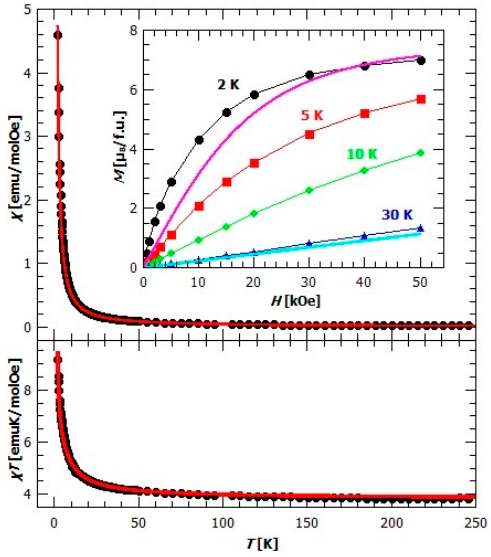
Figure 11. Up: temperature dependence of susceptibility 𝜒 for compound 3 in field of 1000 Oe. The red line represents fitted curve. Inset: field dependence of magnetization at different temperatures. Pink and blue lines represent the sum of Brillouin functions for spins of Cu 2+ and Cr 3+ . Down: temperature dependence of 𝜒𝑇 in the field of 1000 Oe. The red line is fitting curve.